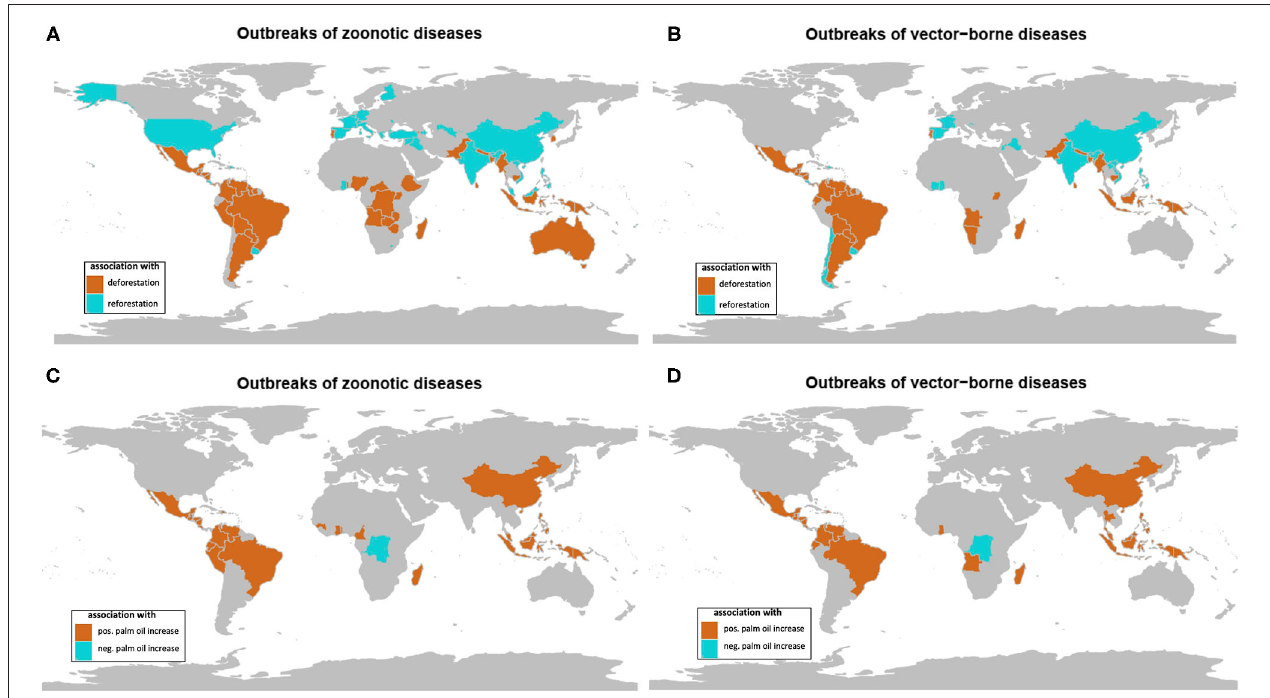
FIGURE 4 | Maps of significant association between forest cover change (deforestation in brown, reforestation in blue) and (A) outbreaks of zoonotic diseases and (B) outbreaks of vector-borne diseases on temporal trends from 1990 to 2016. Maps of significant association between oil palm area change and (C) outbreaks of zoonotic diseases and (D) outbreaks of vector-borne diseases (positive association in brown, negative association in blue) on temporal trends from 1990 to 2016 (data from GIDEON and FAOSTAT) (see Supplementary File ).